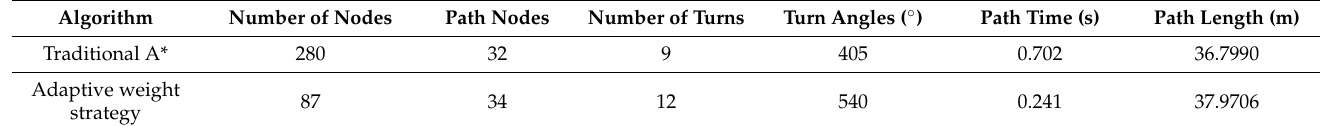
Table 2. Comparison between the traditional A* algorithm and the adaptive weight strategy